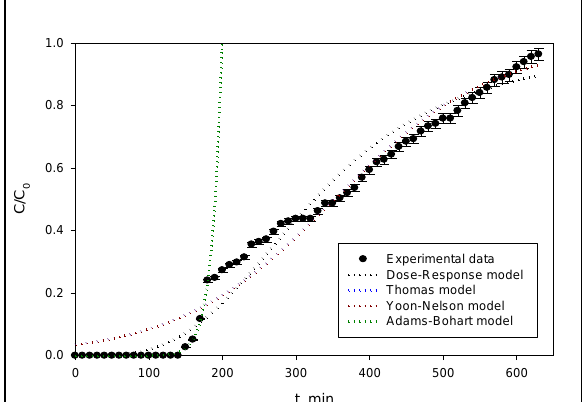
Figure 6: Non-linear plot of Thomas, Yoon-Nelson, Adams-Bohart and Dose-response models for the adsorption of phenol using 65.0 g of SBFA.